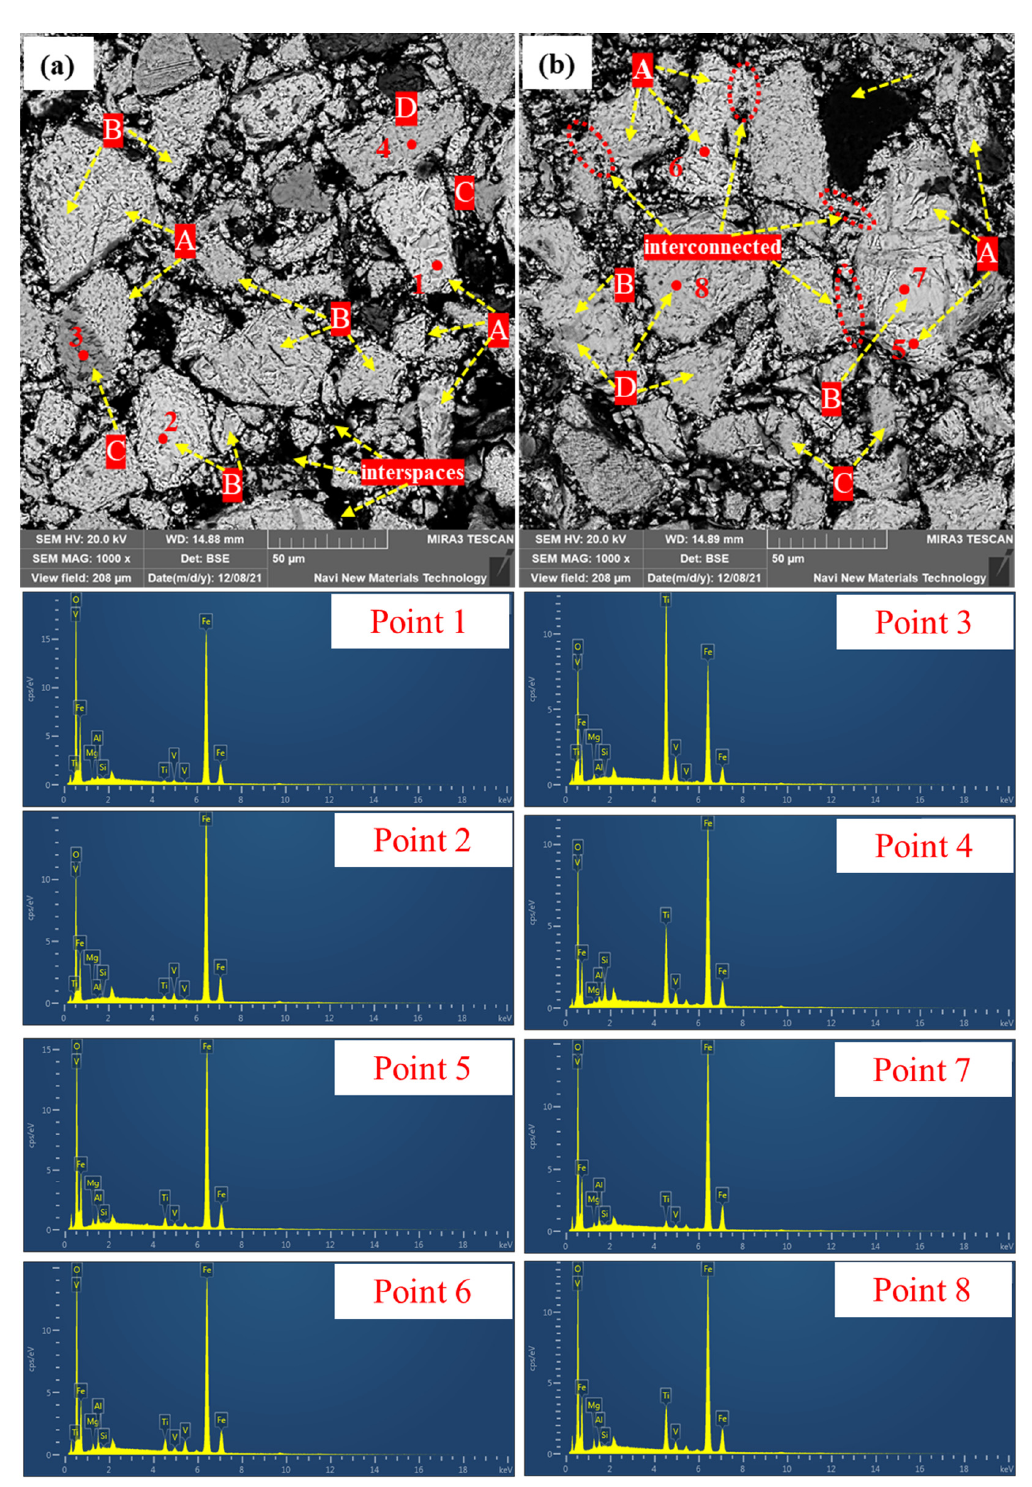
Figure 12. SEM–EDS spectra of the HB preheated pellets at different preheating times (( a ) 10 min; ( b ) 16 min) . A—hematite; B—magnetite; C—ilmenite; D—titanomagnetite.